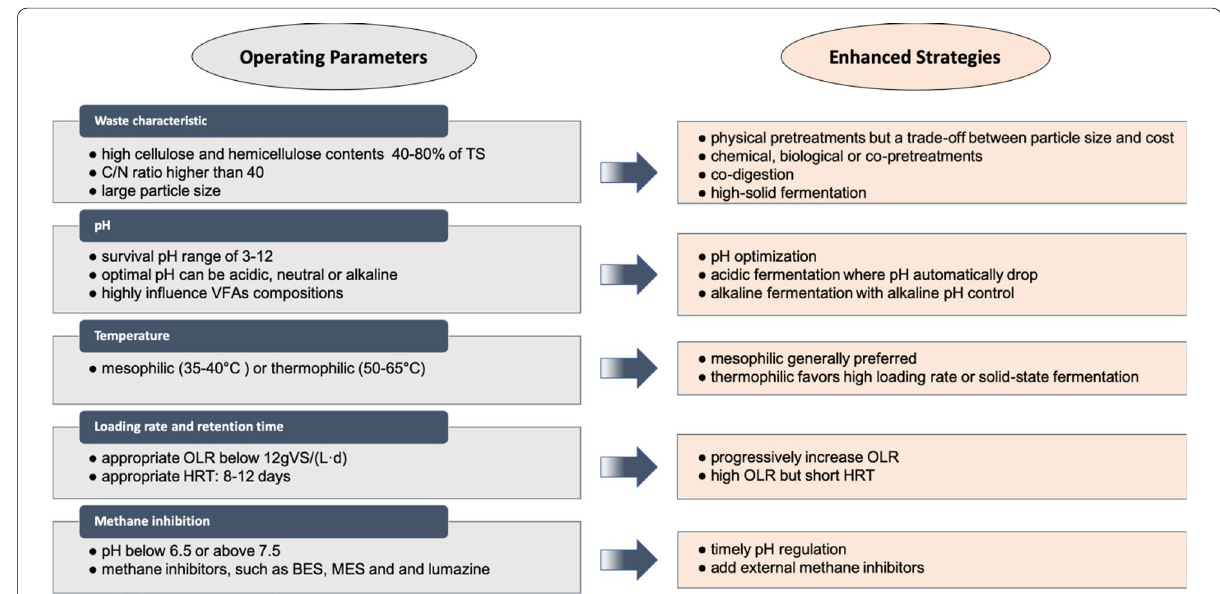
Fig. 3 Workflow for optimization of operating parameters during acidogenic